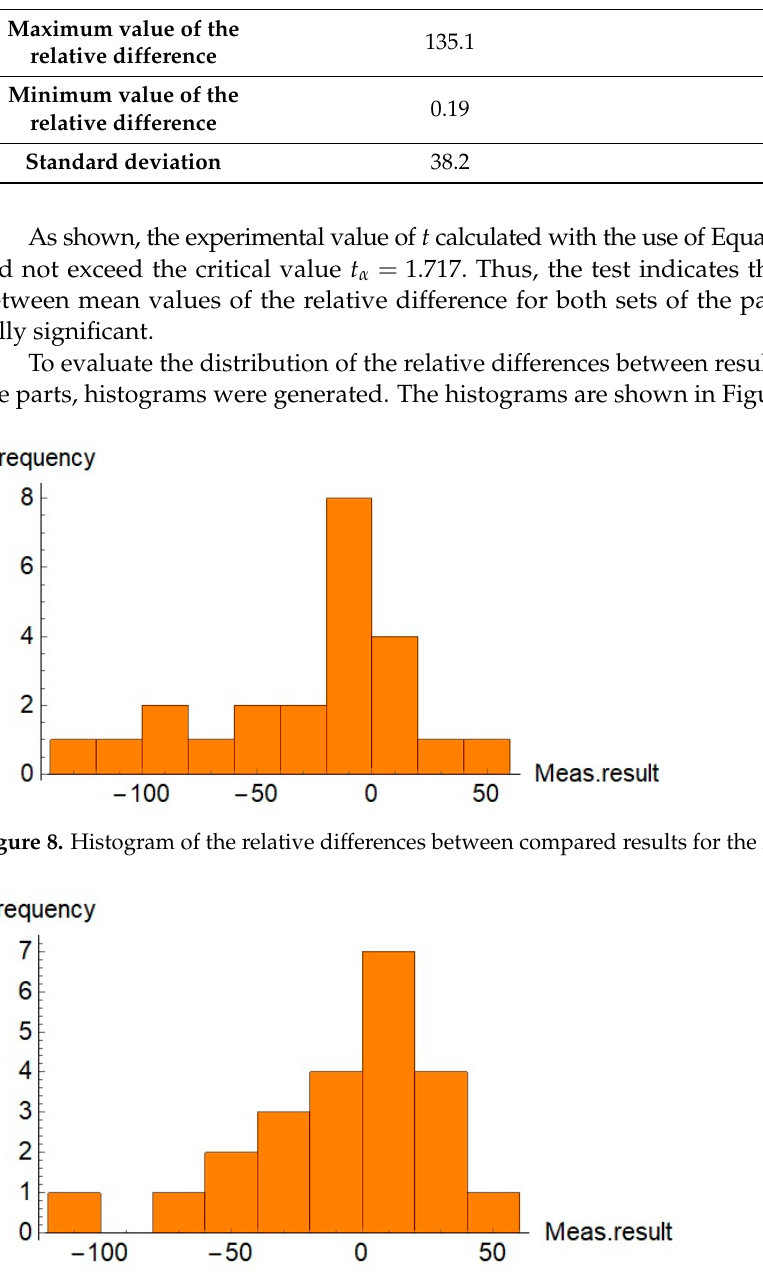
Table 4. Results of the application of the function FindDistribution to measurement datasets. The Number of the Measure-